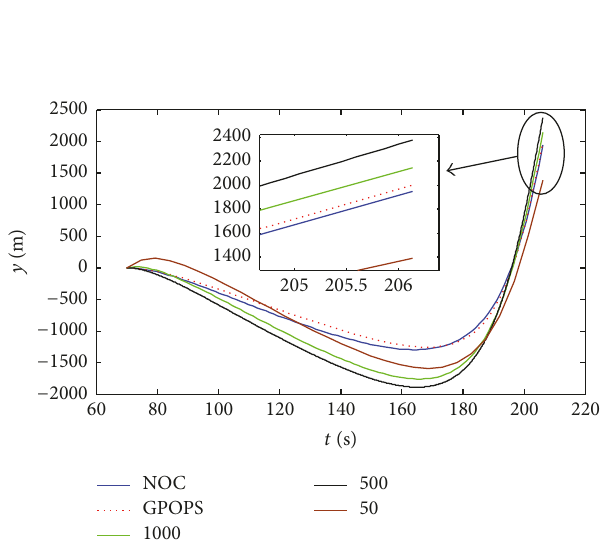
Figure 5: Comparison of altitude modification.